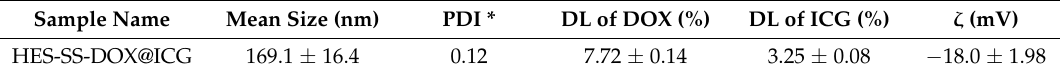
Table 1. Parameters for